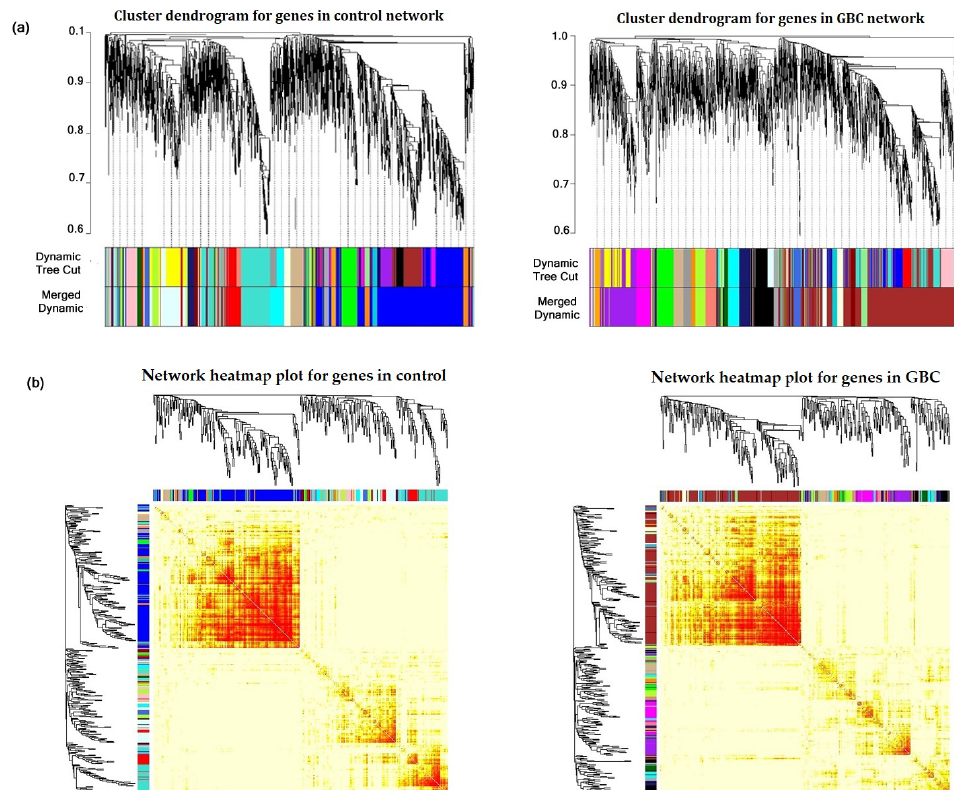
Figure 2. Construction of differential gene co-expression networks. ( a ) Clustering dendrogram of modules in control network and GBC network respectively. ( b ) Clustering dendrogram heatmap plot with module colors based on topological overlap for control and GBC network